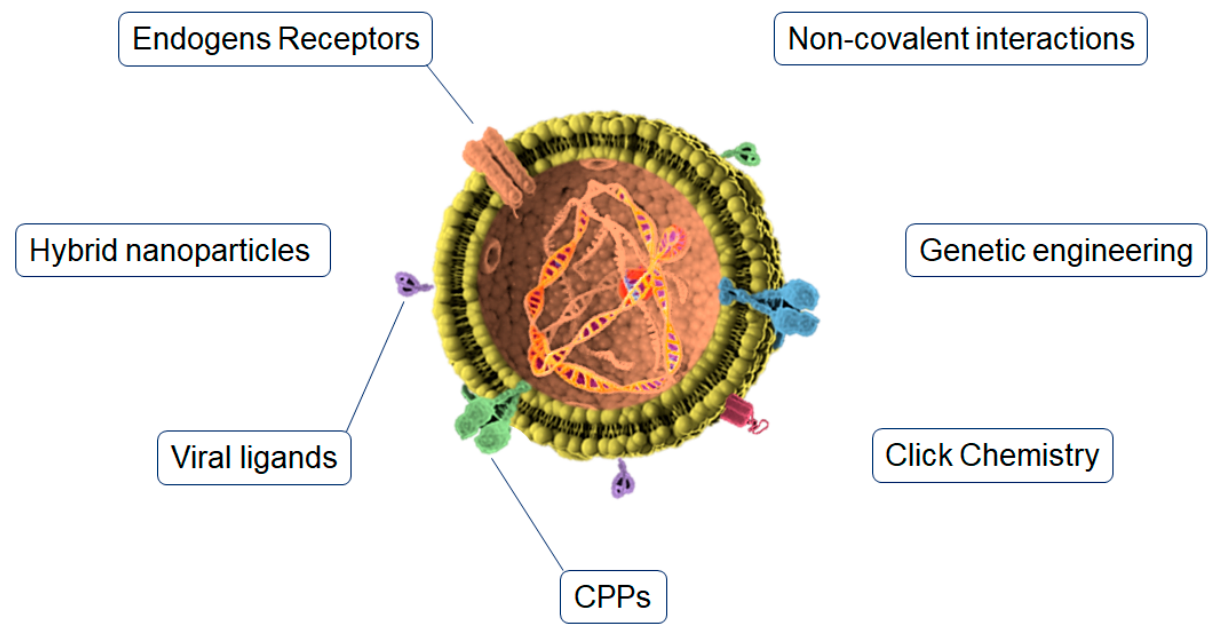
Figure 2. Functionalization strategies for brain targeting of exosomes.